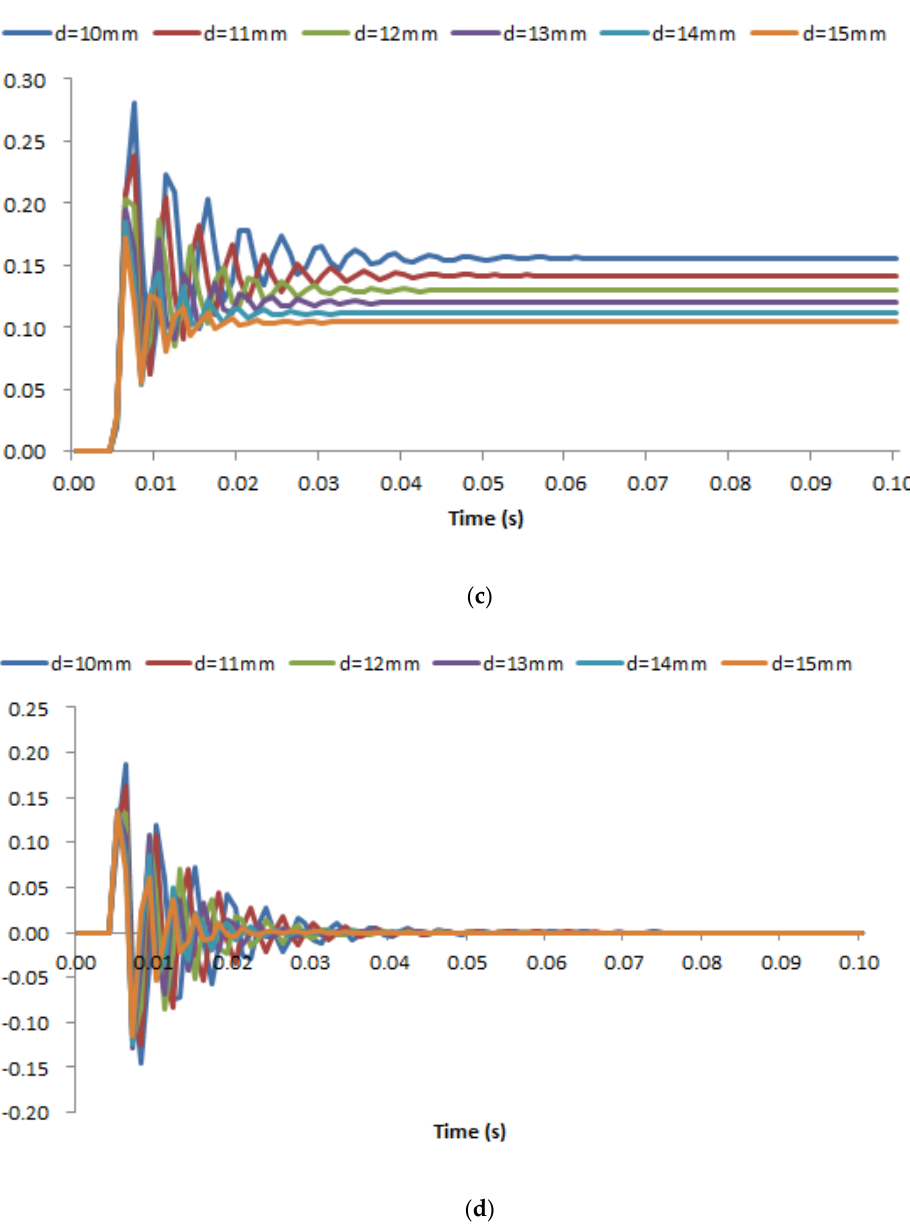
Figure 15. ( a ) The pressure response characteristics — valve element diameter: 10~15 mm. ( b ) The flowrate response characteristics — valve element diameter: 10~15 mm. ( c ) The displacement response characteristics — valve element diameter: 10~15 mm. ( d ) The velocity response characteristics — valve element diameter: 10~15 mm.